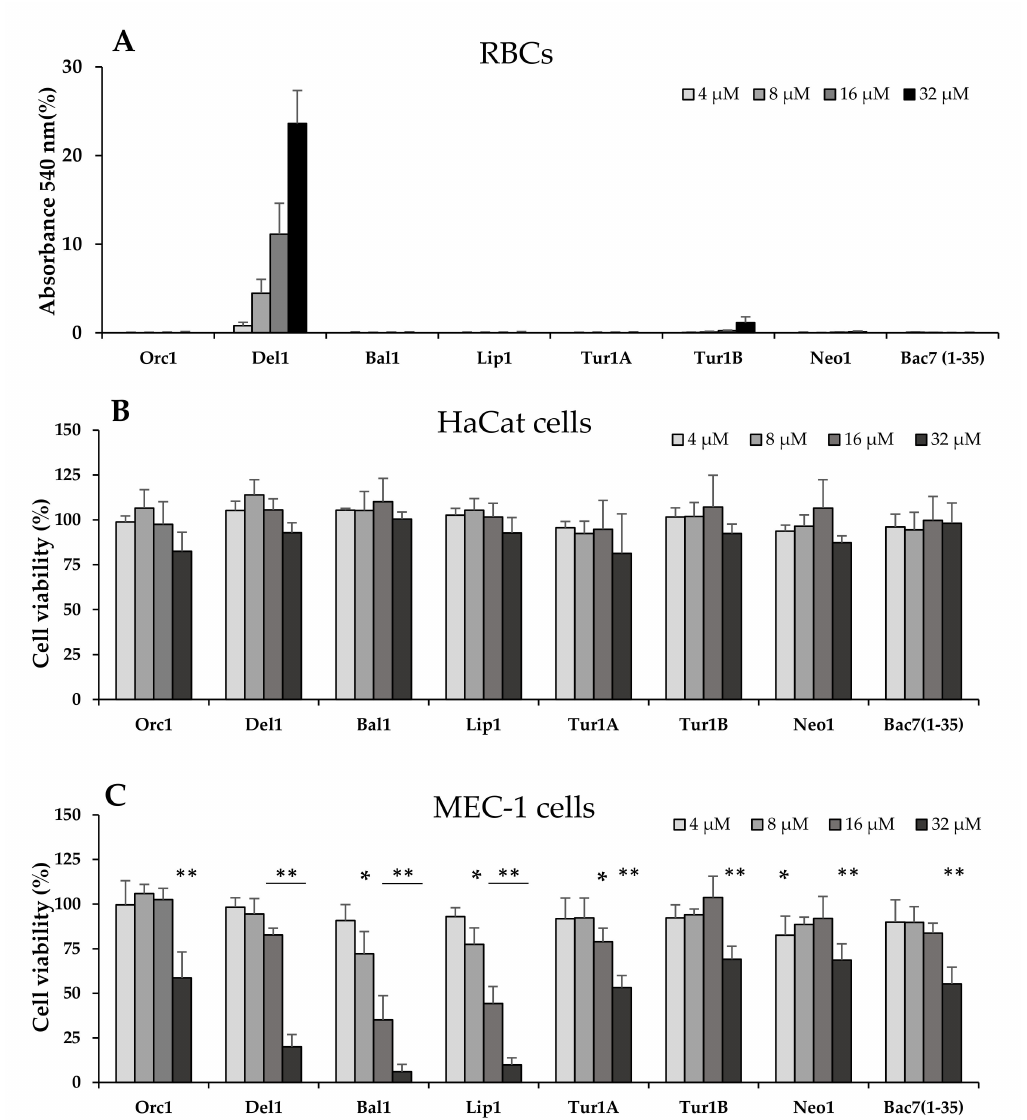
Figure 4. Evaluation of in vitro toxicity of CePrAMPs. ( A ) Hemolysis assay against human red blood cells (hRBCs), re-suspended in PBS at 4% ( v / v ) concentrations, measured as the absorbance of released hemoglobin (540 nm) after 1 h of exposure to the peptides. Results are reported as percentages with respect to hRBCs treated for 1 h with 1% Triton X-100 (considered as 100%), and are the average of three independent experiments ( n = 3); ( B , C ) Evaluation via MTT assay of the viability of the indicated eukaryotic cell lines after exposure to the peptides. HaCat ( B ) or MEC-1 ( C ) cells were incubated with the di ff erent peptides at increasing concentrations for 21 h ( B ) or 20 h ( C ), before treating cells with MTT. Results are reported as the percentage of viable cells with respect to the untreated control, and are the average of three independent experiments ( n = 3) (* = p < 0.05; ** = p <